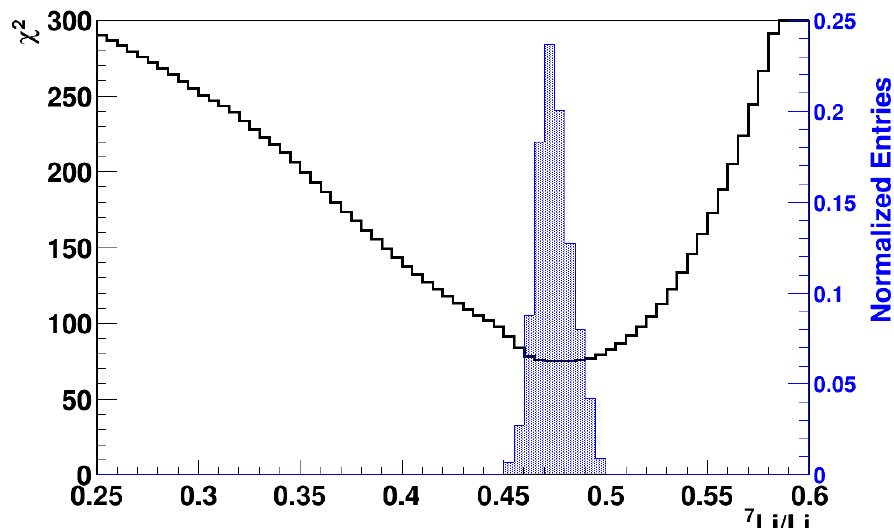
Figure 3. χ 2 configurations obtained by data-driven analysis for lithium events collected by PAMELA- ToF in the 0.25–0.75 GeV/n region (black line). The best-fit probability distribution obtained by statistical bootstrap is shown for comparison (blue histogram).